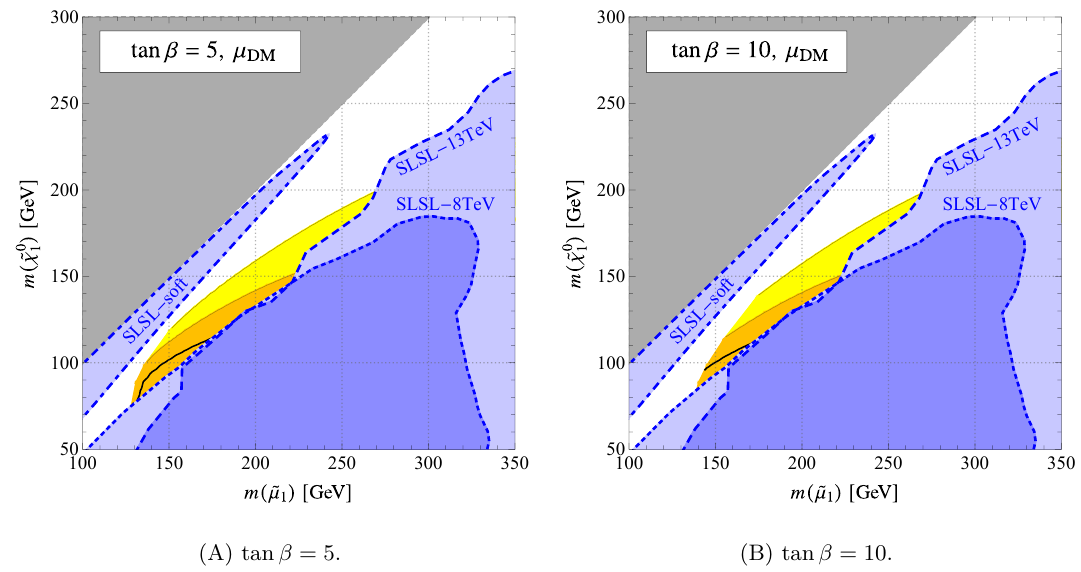
Figure 3. The bino-dominated SUSY scenario for the muon g − 2 anomaly with proper dark matter relic abundance. In the same way as figure 2, the universal slepton mass with m used, but the µ parameter is tuned ( µ and 10 . In the orange-filled (yellow-filled) regions, the muon g − 2 anomaly can be solved at the 1 σ ( 2 σ ) level while satisfying the XENON1T